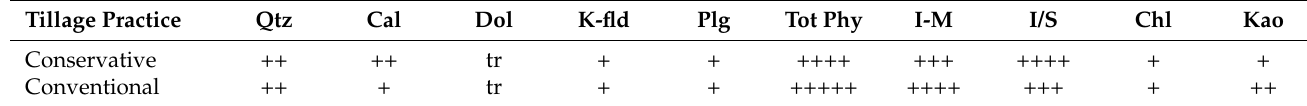
Table 1. Mean mineralogical composition of the bulk (Qtz to Tot Phy) and <2 µm fractions (I-M to Kao) of the studied samples grouped by tillage practice (Qtz = quartz; Cal = calcite; Dol = dolomite; K-fld = K-feldspar; Plg = plagioclase; Tot Phy = total phyllosilicates; I-M = illite-mica; I/S = illite/smectite; Chl = chlorite; Kao = kaolinite; tr = 0 ÷ 3%; + = 3 ÷ 10%; ++ = 10 ÷ 20%; +++ = 20 ÷ 40%; ++++ = 40 ÷ 70%; and +++++ = 70 ÷ 100%).